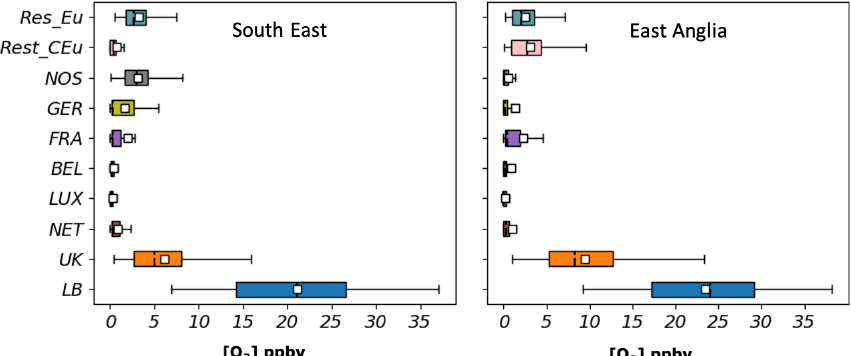
Figure 12. Hourly contributions (in ppbv) to surface O 3 at 2 UK receptor regions from 10 source regions (UK, background (LB), the Netherlands, Luxembourg, Belgium, France, Germany, the rest of central Europe, the North Sea and English Channel (NOS), and the rest of Eu) for the AOT40 between May and August. The lower and upper ends of the boxes indicate the 25th and 75th percentiles, the dashed black line the median, the white boxes the mean, and the whiskers the minima and